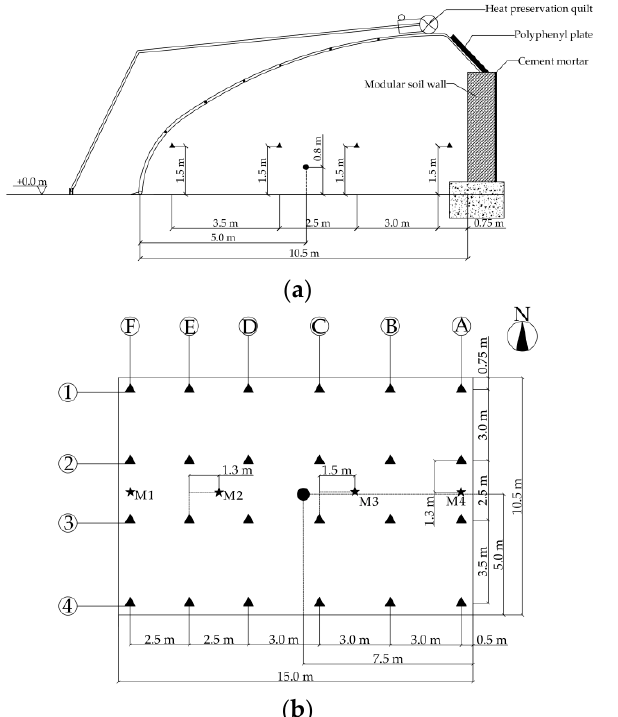
Figure 2. Distribution of indoor temperature and solar radiation sensors. ( a ) The distribution of temperature and solar radiation sensors in the vertical direction; ( b ) The distribution of temperature and solar radiation sensors on the horizontal plane. ▲ is Pt100 temperature sensor; ● is solar radiation sensor. ★ is Pt100 temperature sensor used to obtain the observation value and analyze the estimate interpolation effect. Where 1 to 4 are row marks; A to F are column marks; M1 to M4 are sensor numbers.